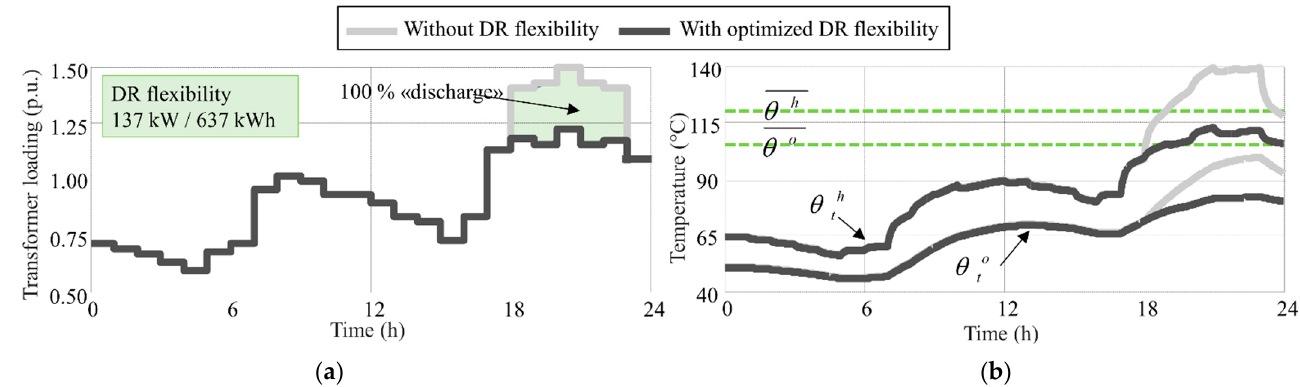
Figure 12. Validation run with “energy shedding” and aging: ( a ) transformer loadings; ( b )